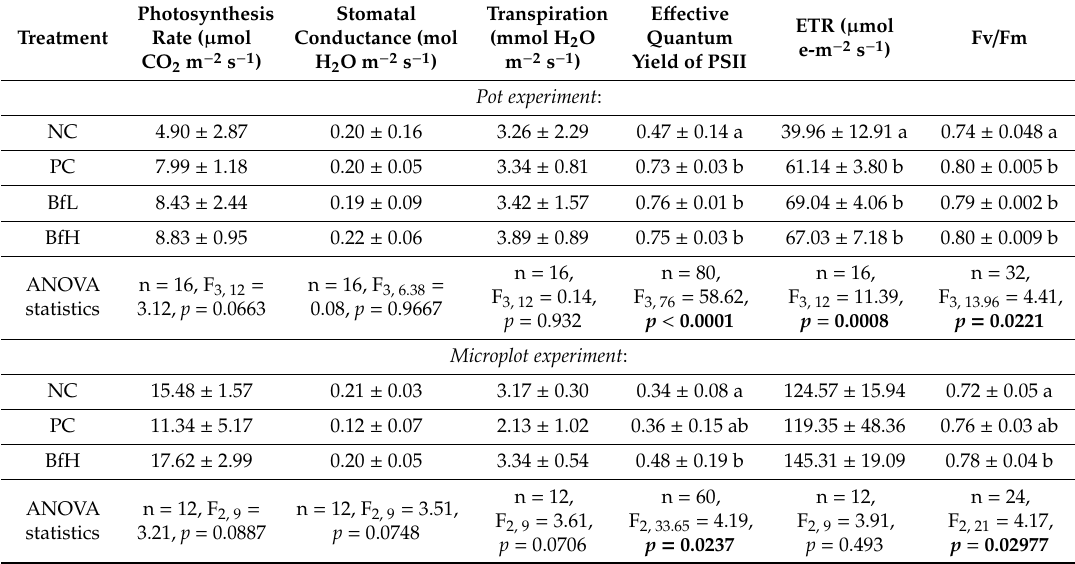
Table 4. Physiological parameters assessing plant photosynthesis and chlorophyll a fluorescence at the end of both experiments with di ff erent